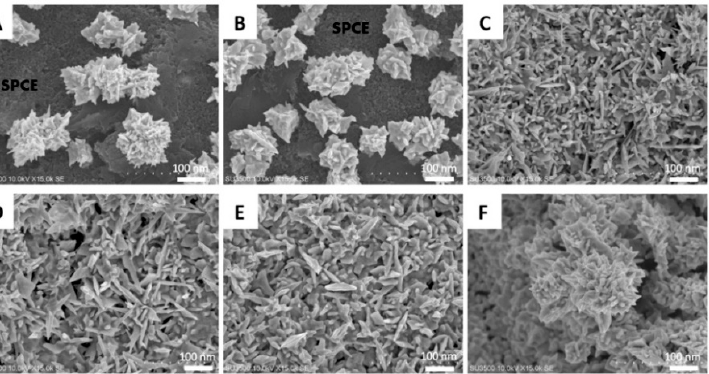
Figure 1. SEM images of electrodeposited Au nanostructure at potentials deposition of ( A ) +0.1 V, ( B ) +0.05 V, ( C ) − 0.05 V, ( D ) − 0.1 V, ( E ) − 0.2 V, and ( F ) − 0.3 V (vs Ag/AgCl). The coverage of the